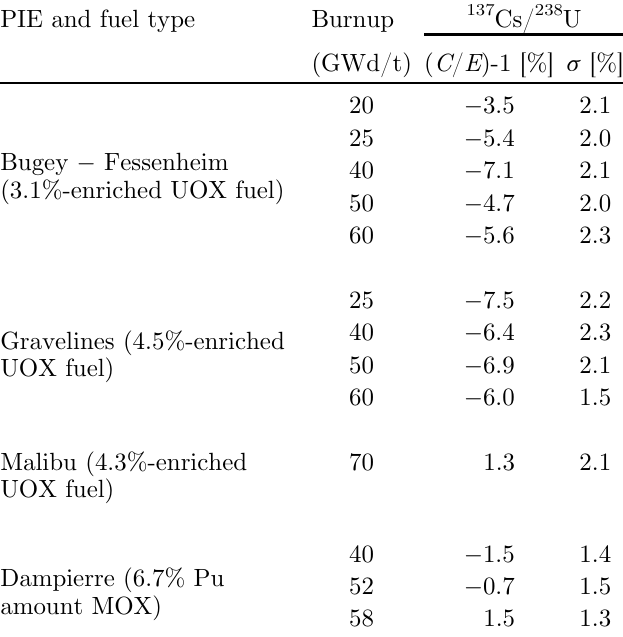
Table 1. Results of the DARWIN2.3 experimental validation of 137 Cs in PWR fuels (1 s standard deviation) [2]. PIE and fuel type